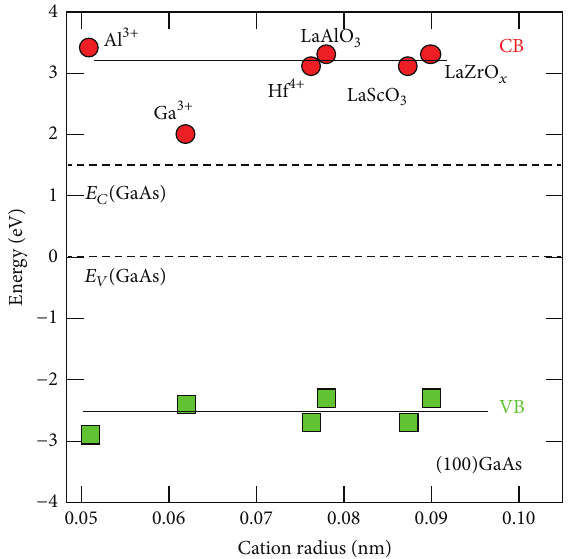
Figure 25: Energies of the VB top and CB bottom in different oxides as a function of cation radius referenced to the band edges for GaAs crystal as inferred from the IPE experiments. The top of the GaAs VB is at 𝛿𝐸 𝑉 = 0.2 eV below the silicon VB as measured relative to the common a-Al 2 O 3 CB bottom reference level.